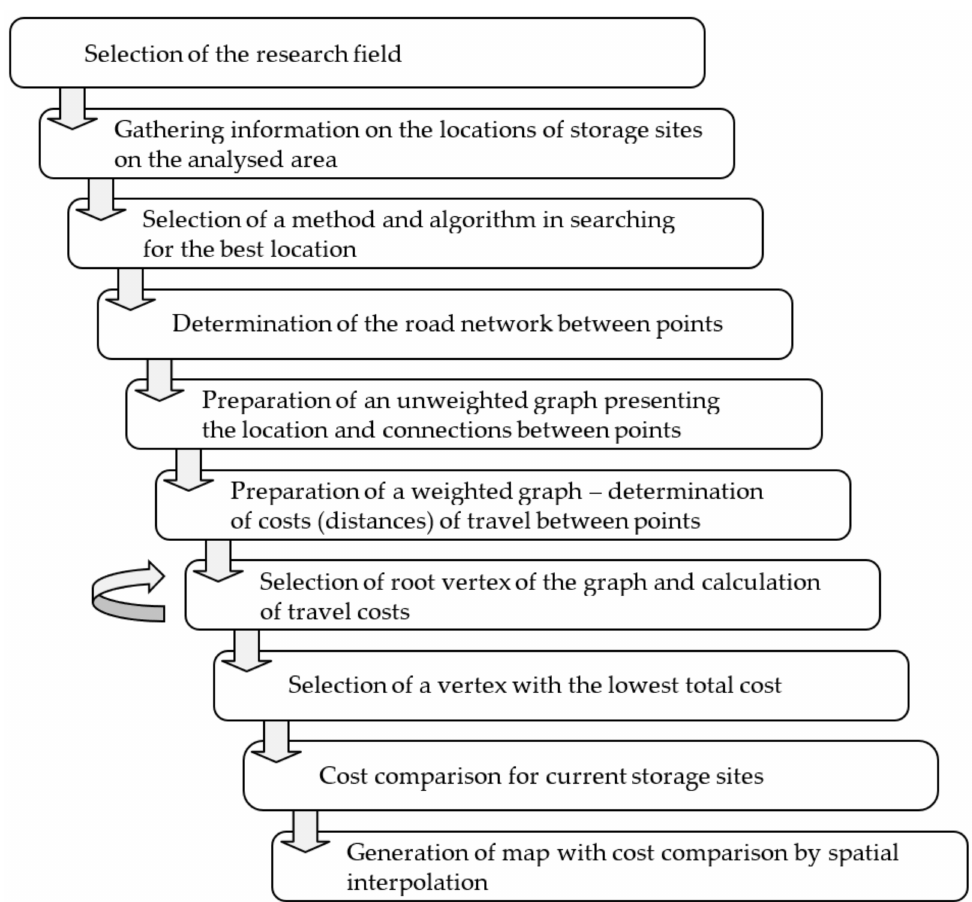
Figure 1. The order of procedures in the research methodology.